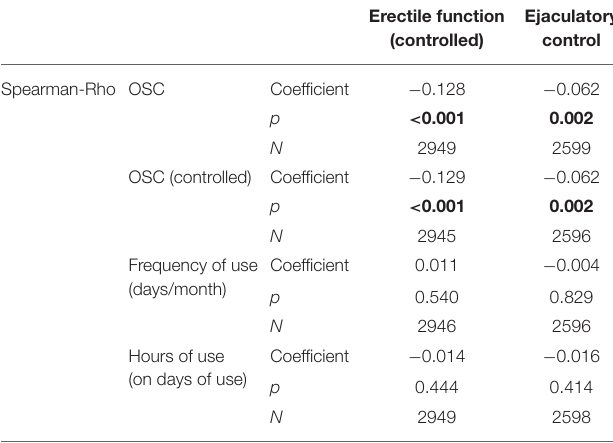
Erectile function Ejaculatory (controlled) control